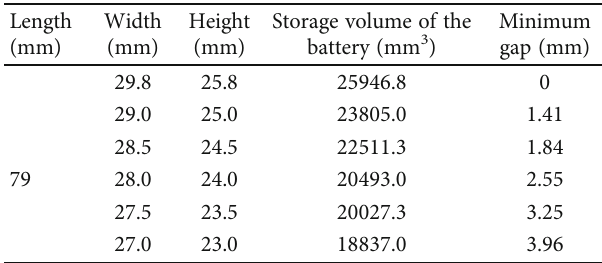
Figure 3: Battery box fi lling and installation schematic. Table 1: Battery box design